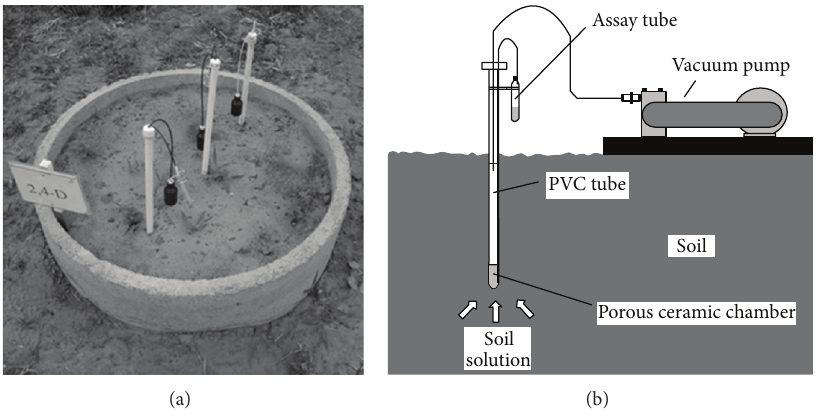
Figure 1: (a) Undisturbed soil in cement cylindrical containers. (b) Soil solution extraction system.